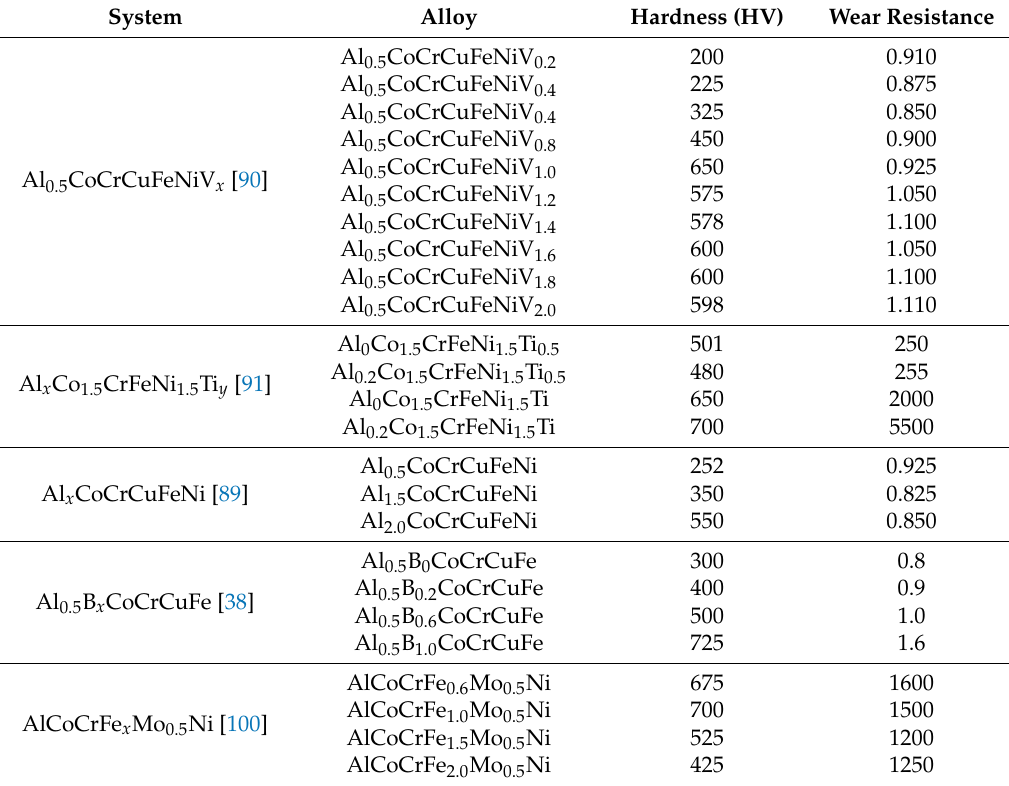
Table 3. Sumamry of wear behavior of alloys reported in